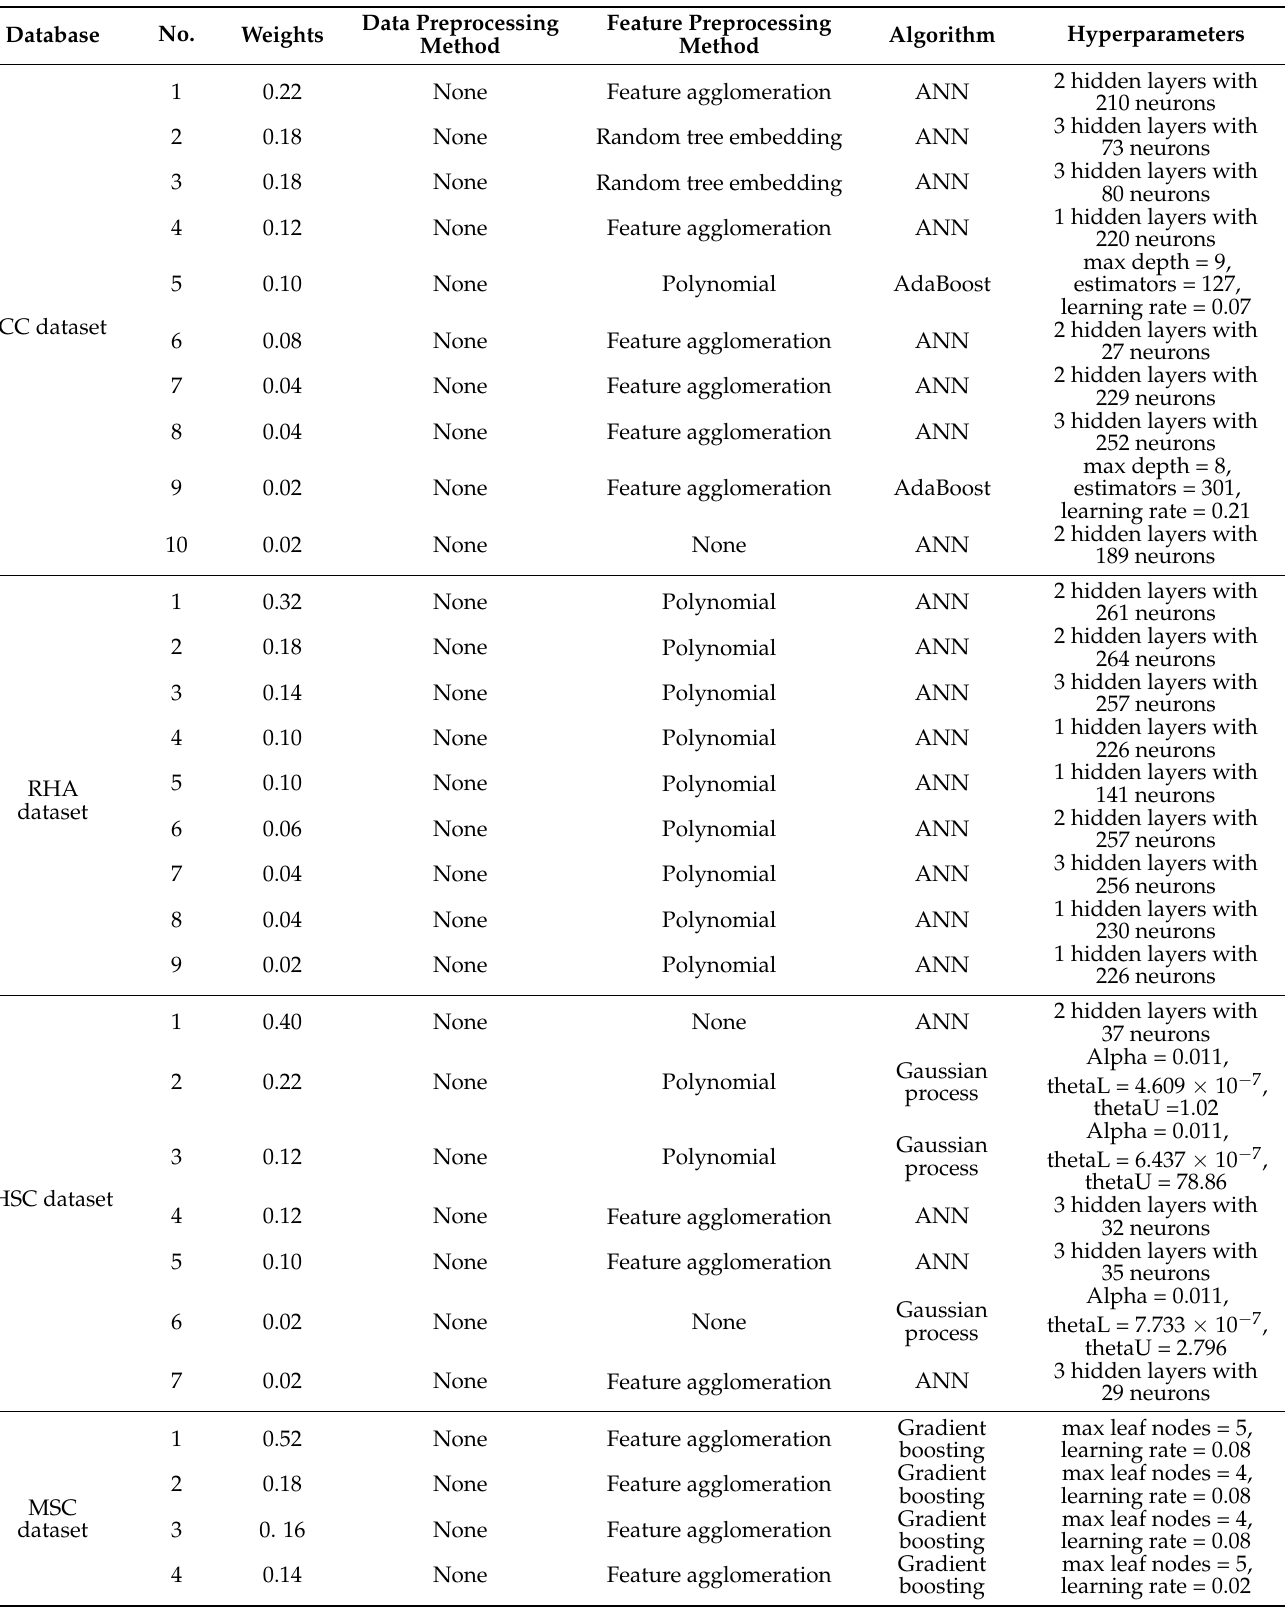
Table 6. Four optimal models searched by